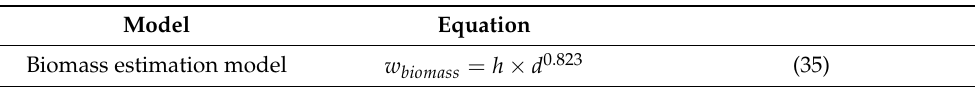
quantity calculated; h —height; d —diameter.